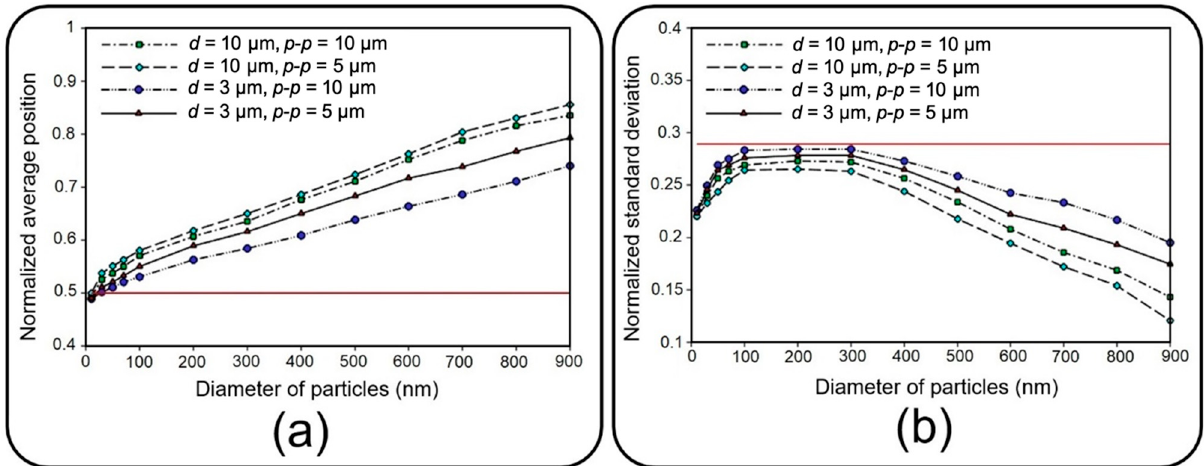
Figure 13. Normalized ( a ) average position and ( b ) standard deviation of transferred NPs of diameters ranging from 10 nm to 900 at the outlet of the media channel in the lung-on-a-chip device with different membrane porosities under the fluid velocity of 0.3 mm/s. The solid red line corresponds with an ideal distribution in the media